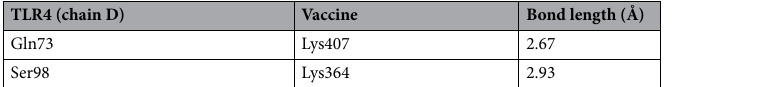
Table 6. List of residues in the docked complex that are involved in hydrogen bonds between the vaccine and TLR4 (chain D).